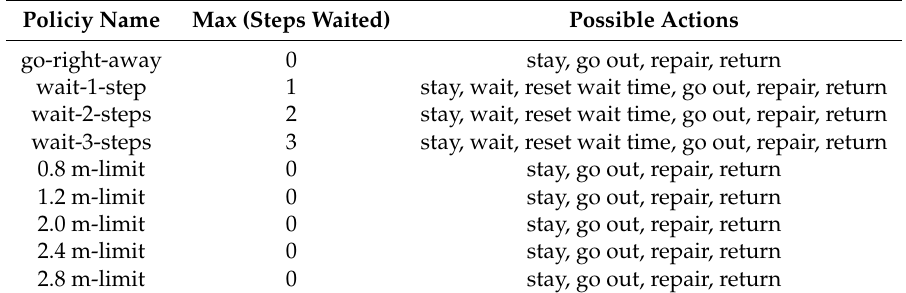
Table 3. Names of the different policies investigated in this article, as well as the maximum number of steps that can be waited under this policy and the possible